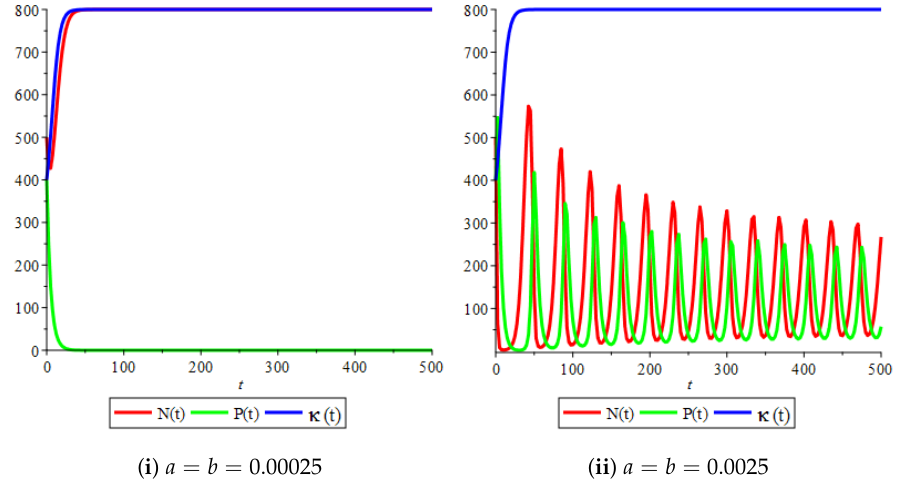
Figure 4. Prey–predator model with Holling type II functional response and logistic carrying capacity, stability of E 4 and E 6 , κ 1 = 300, κ 2 = 500, r = c = 0.25, γ = 0.002, α = 0.2.